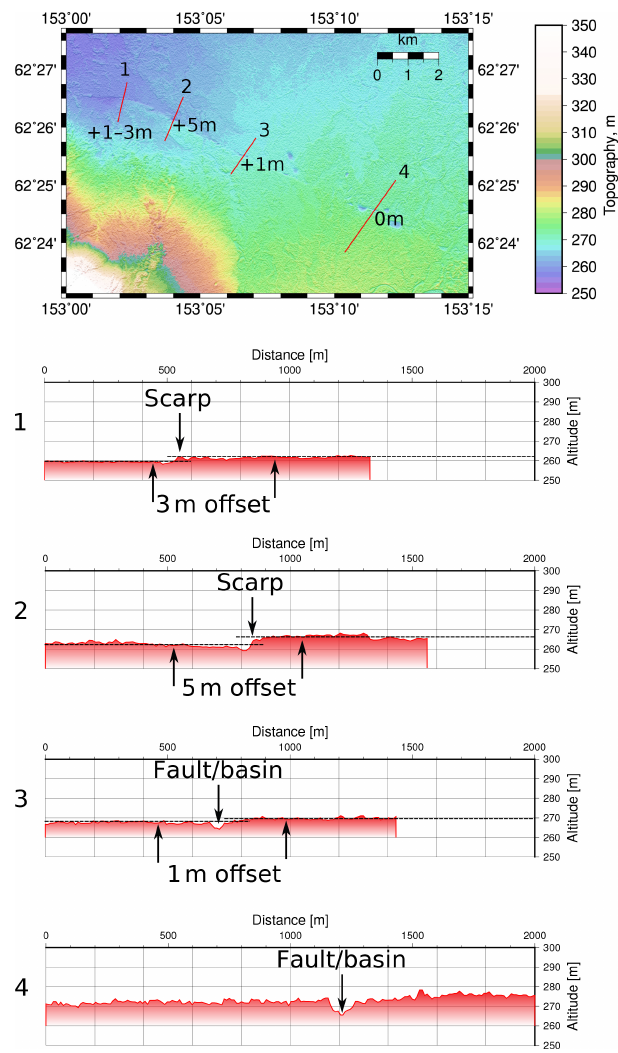
Figure 7. Topographic profiles, showing vertical offsets across the scarp on the Buyunda fan. Offsets are close to maximum near Lake Rovnoye (profiles 1 and 2) but diminish eastwards over a distance of ∼ 5km. From Lake Rovnoye westwards there is also no vertical offset. Dashed lines are estimated average elevation of surface either side of fault for determining vertical